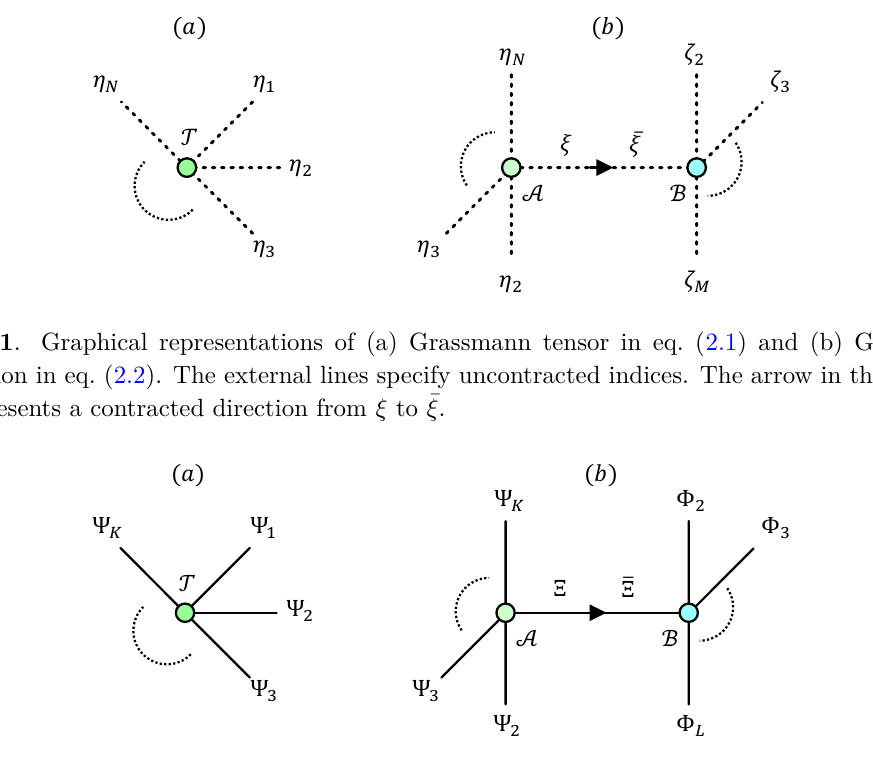
Figure 2 . Graphical representations of (a) Grassmann tensor in eq. (2.3) and (b) Grassmann contraction in eq. (2.4). The external lines specify uncontracted multi-component indices. The arrow in the internal line represents a contracted direction from Ξ to ¯Ξ